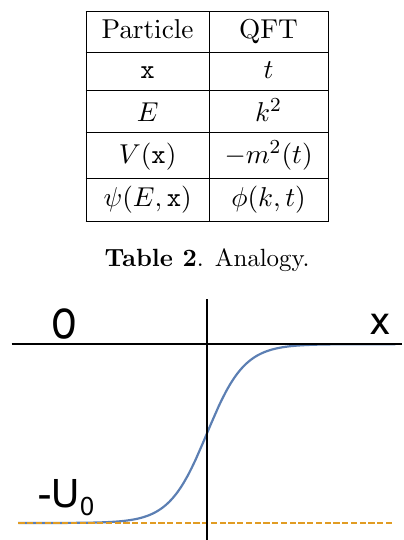
Figure 4 . Scattering of a particle in a potential V ( x ). V ( x ) ! (cid:0) U 0 as x ! (cid:0)1 and ! 0 as x ! 1